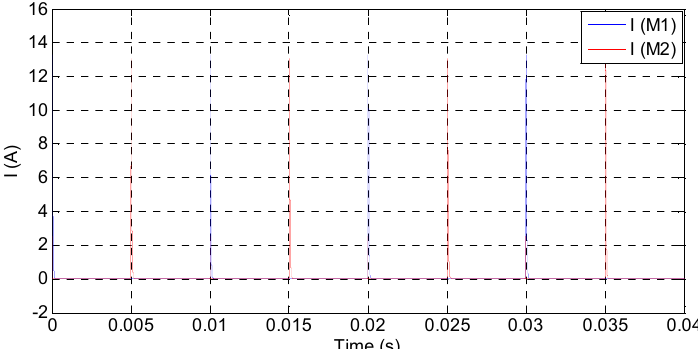
Figure 16. Simulated currents of MOSFETs.